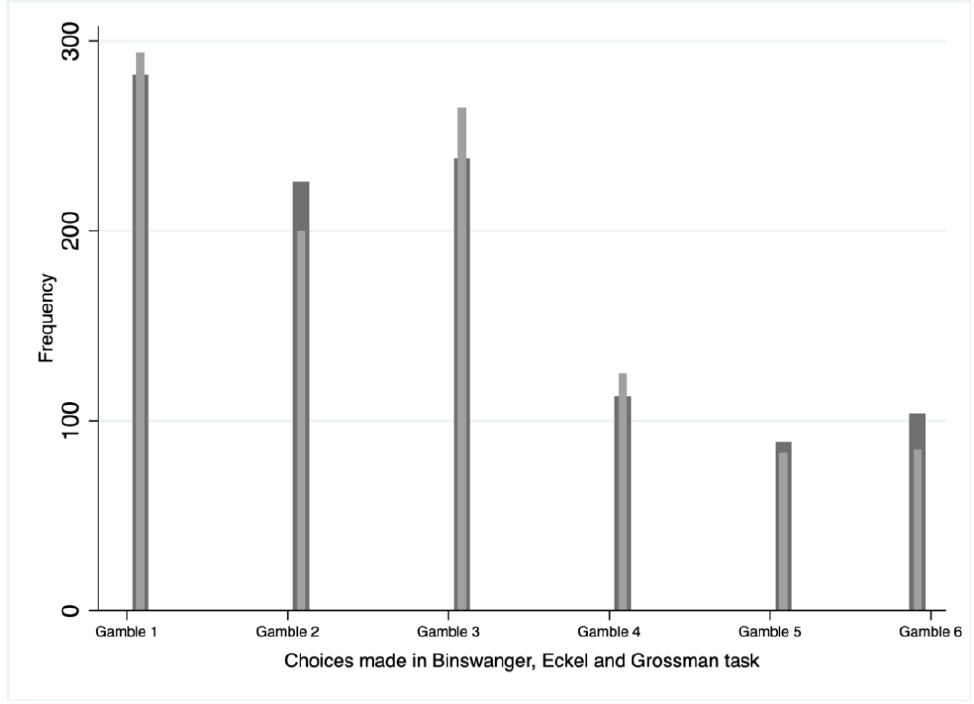
Figure 1. Frequency of choosing different gambles in the Binswanger, Eckel, and Grossman risk tasks. Legend: wider grey bars indicate choices in BEG task 1; narrow grey bars indicate choice in BEG task